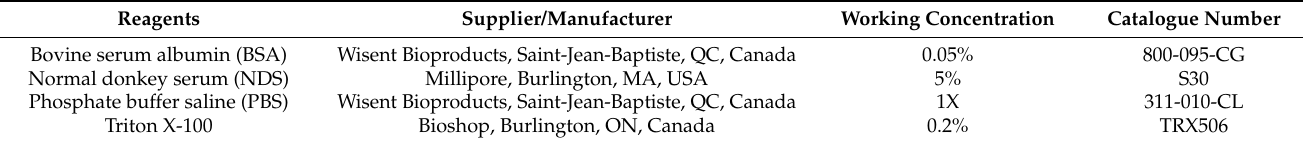
Table 7. Blocking solution composition